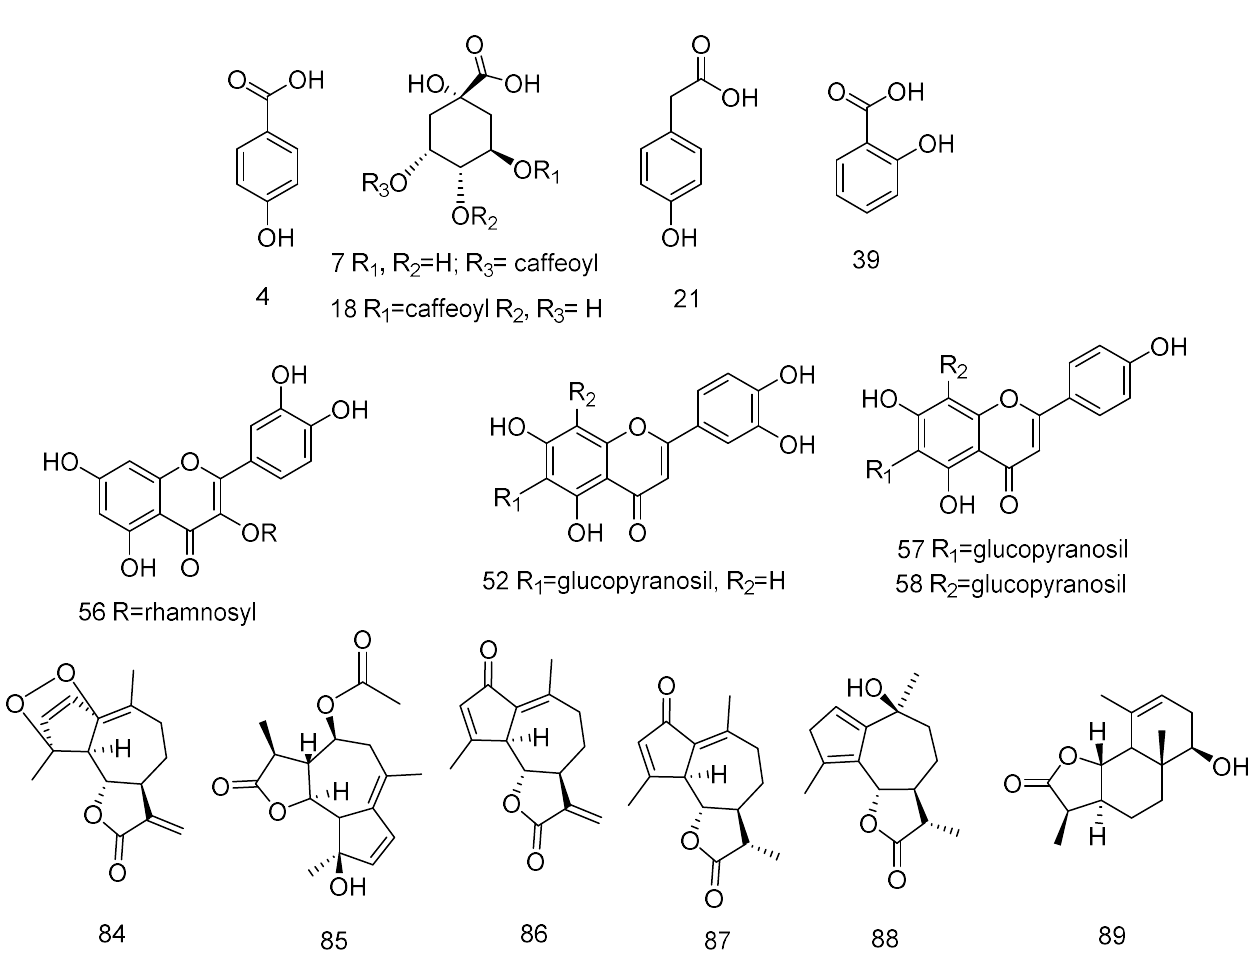
Figure 3. The main components in the tested Achillea extracts (for the compound numbers see Table 2) . A variety of metabolites were identified and tentatively elucidated in the assayed extracts, including, 14 hydroxybenzoic and hydroxycinnamic acids together with 12 phe- nolic acid glycosides and sugar esters, 18 acylquinic acids, 11 C -glycosyl flavones, 2 C , O -